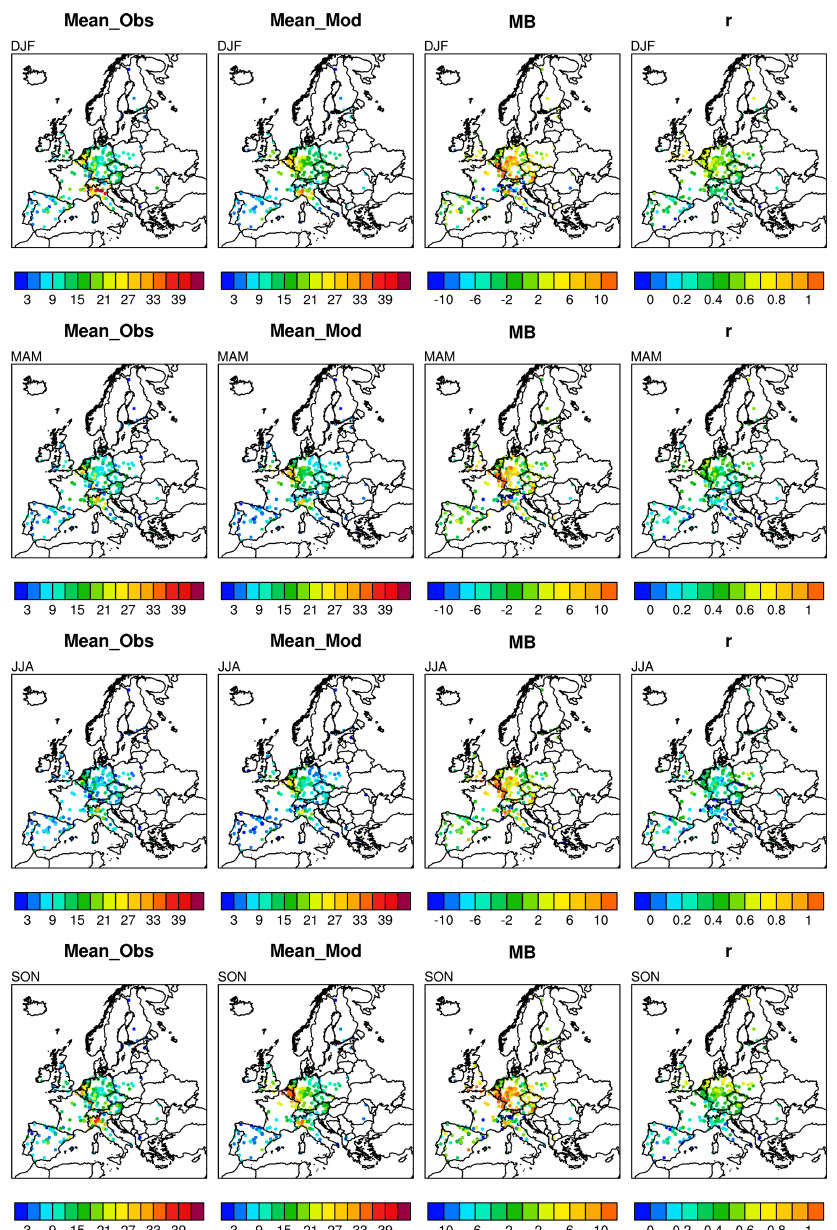
Figure 12. Seasonal average values of surface NO 2 in µgm − 3 from hourly measurements at AirBase (circles) and EMEP (squares) stations, and modeled values from MOZART for corresponding locations. The MB and temporal correlation coefficient ( r ) for hourly values are also shown at the location of station